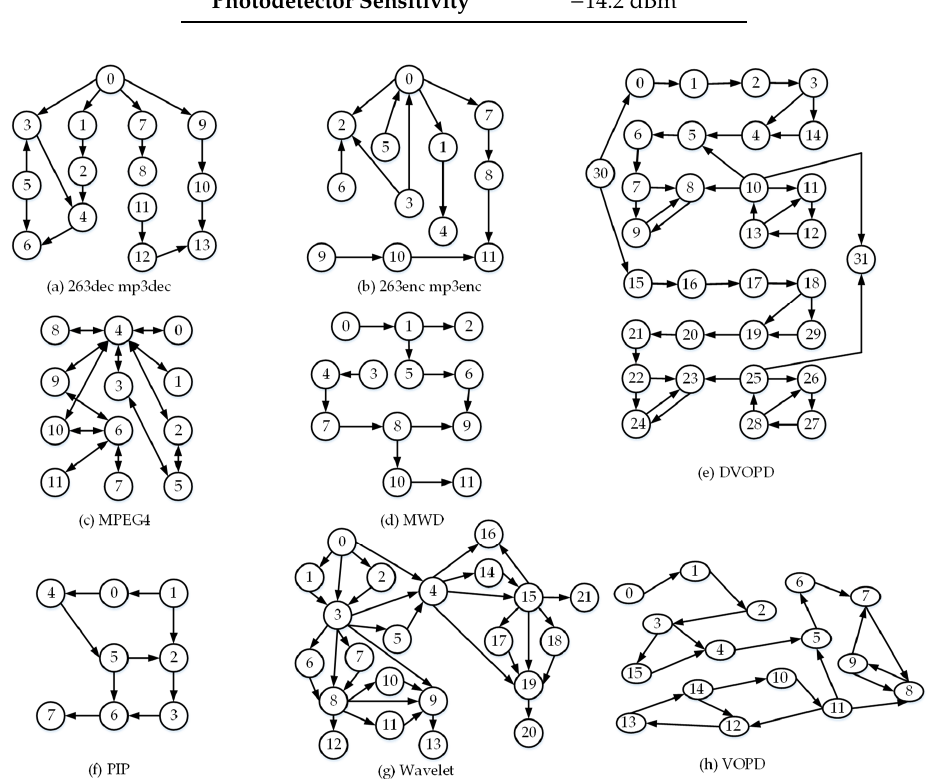
Figure 6. Multimedia application structures.